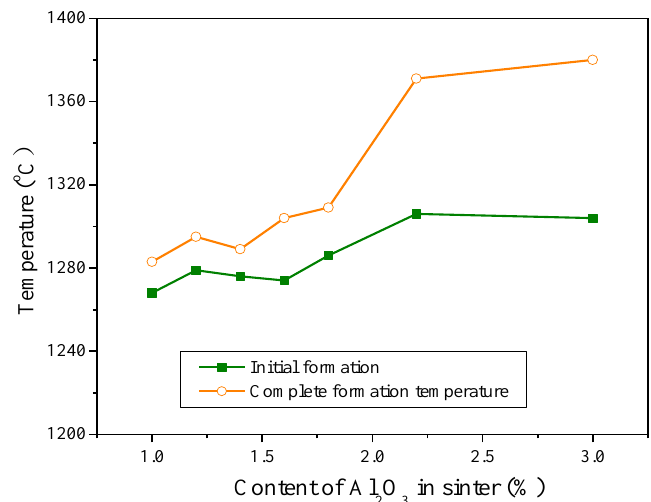
Figure 10. E ff ects of Al 2 O 3 content on the formation temperature of the liquid phase. Figure 10. Effects of Al 2 O 3 content on the formation temperature of the liquid phase.